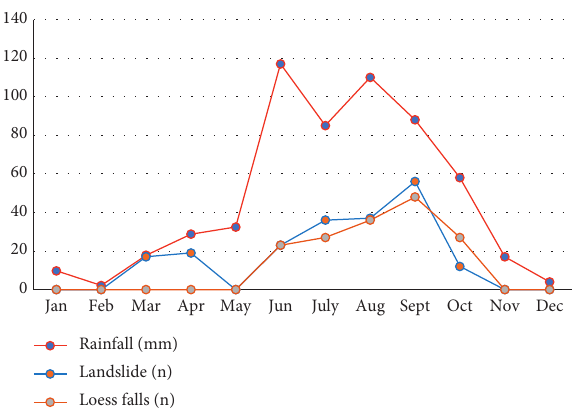
Figure 2: The relation between the landslide occurrence and rainfall. Table 1: Landslide’s